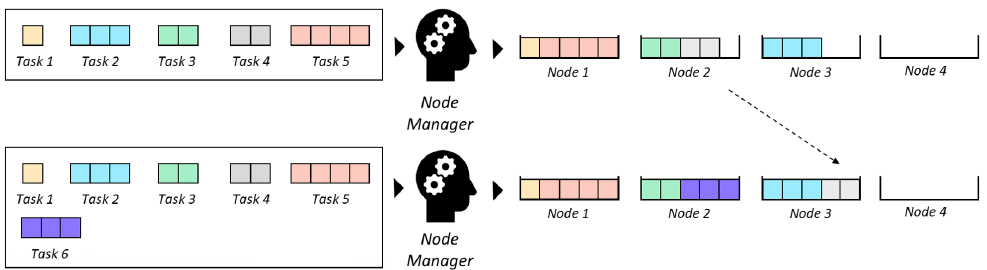
Figure 2. Minimizing the number of active nodes—Illustrative example. A reallocation in order to keep the number of active nodes at a